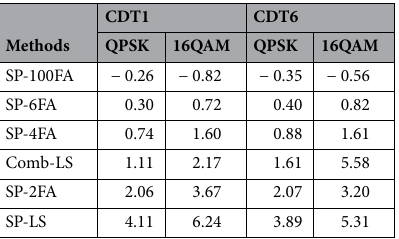
Table 3. The SNR gains of SP-WA than that of other methods at the BER of 10 − 3 (dB).